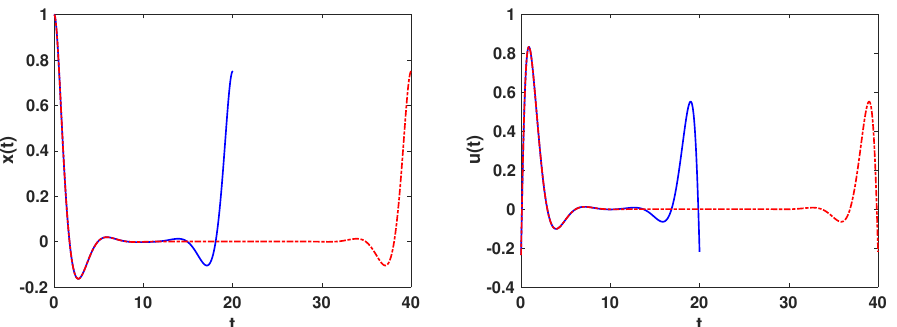
Figure 1. Mass spring: solution in time for the mass position x on the left and the control u on the right. Final time T = 20 (blue line) and T = 40 (red dash-dot line).